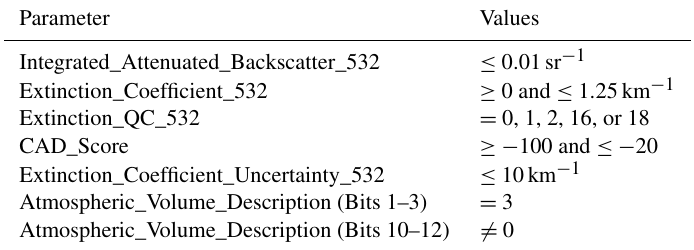
Table 1. The parameters, and corresponding values, used to assure the quality of the CALIOP aerosol extinction profile. Parameter Values Integrated_Attenuated_Backscatter_532 ≤ 0 . 01sr −